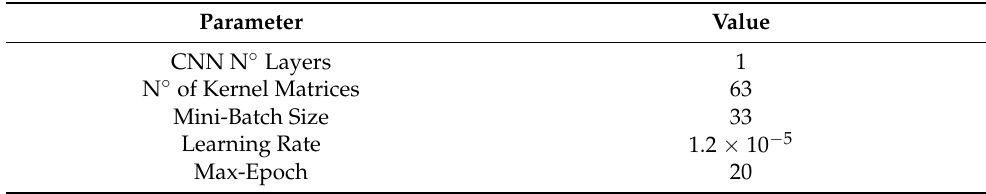
Table 1. DELFI Classifier—CNN Parameters.